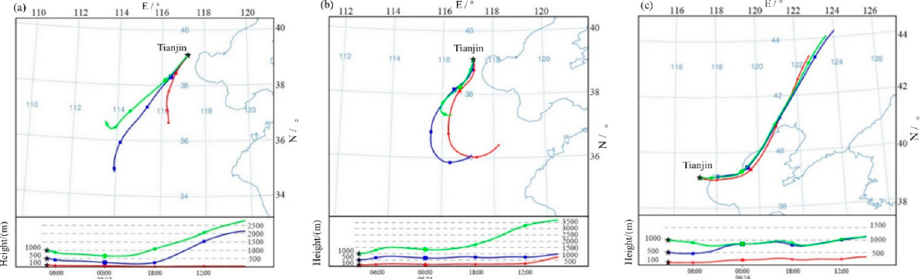
Figure 7. 24-h backward air mass trajectory at 100 m, 500 m, and 1000 m altitudes during different research periods: ( a ) June 12th, ( b ) June 24th, and ( c ) June 16th.